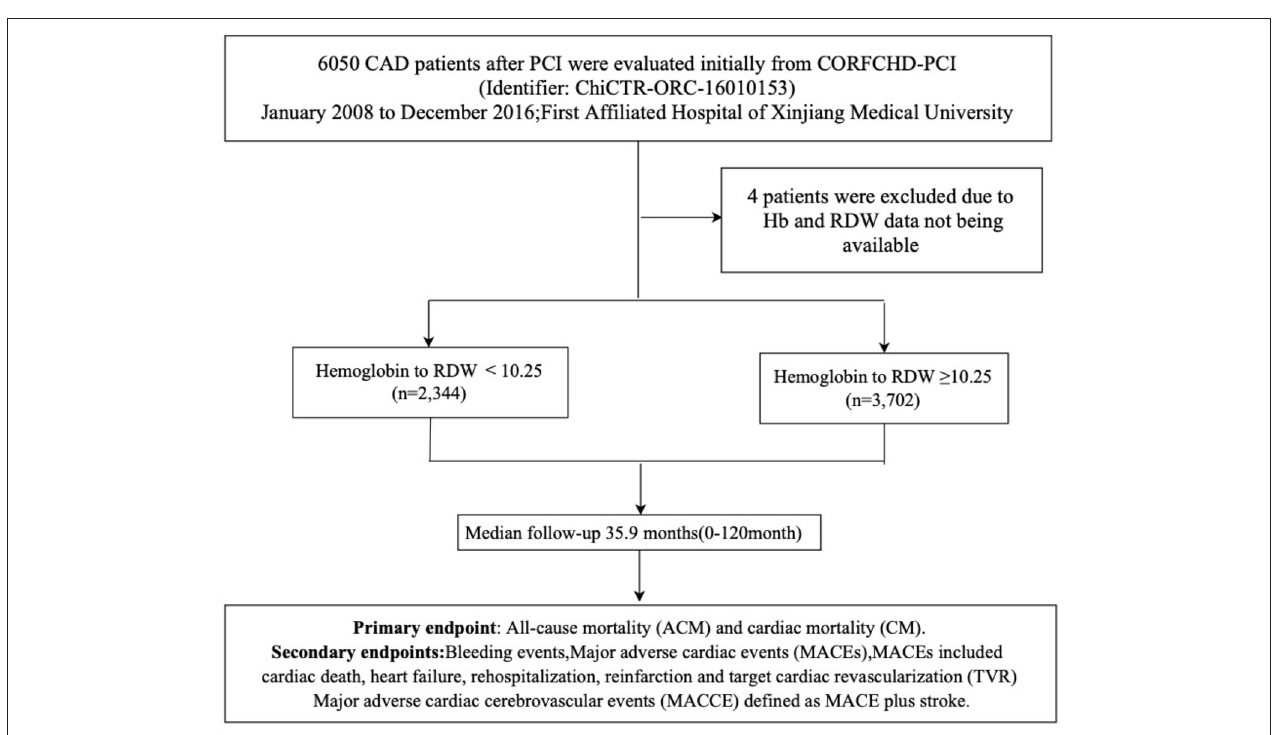
FIGURE 1 | The flowchart of participants